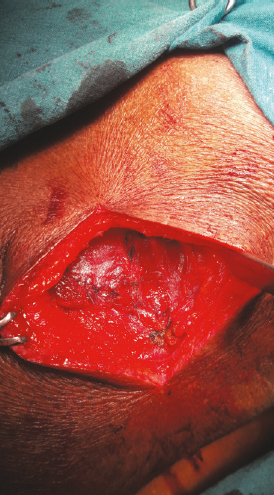
Figure 6: Muscle flaps approximated over the